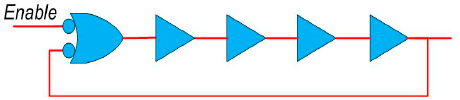
Figure 2. RO5 implemented inside the Cyclone V-chip.